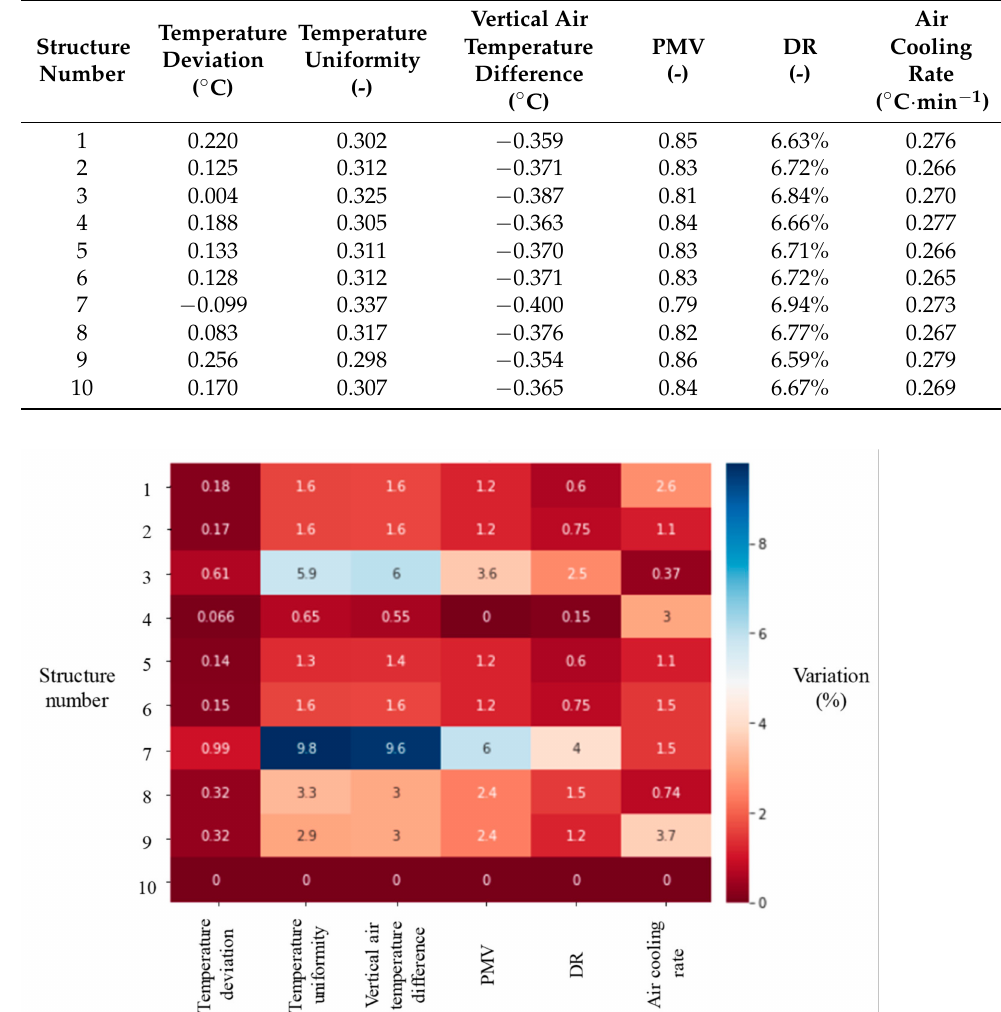
Table 9. Effects of the evaporator structure on the thermal environment.